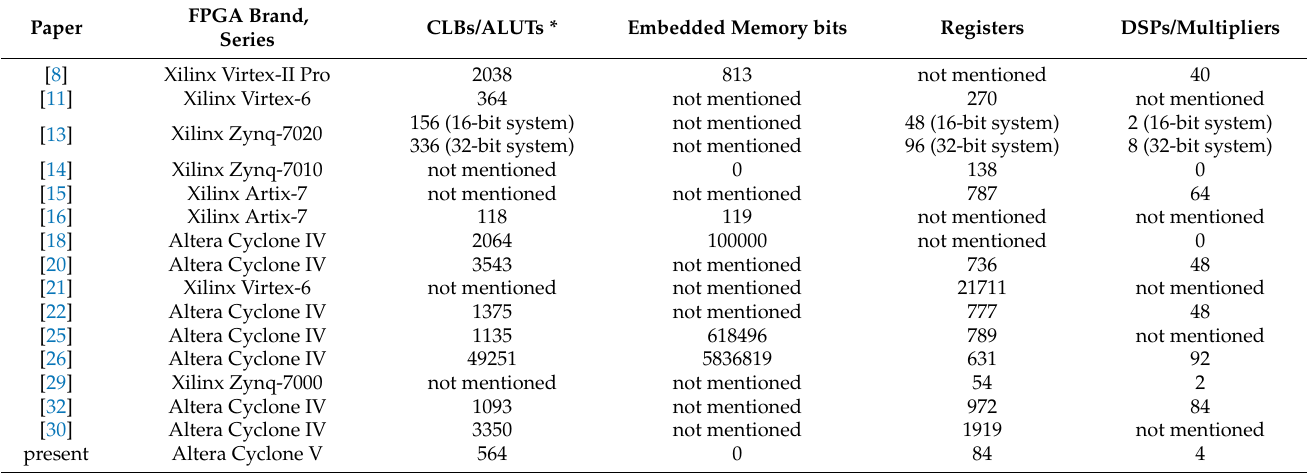
Table 3. Summary of resource usage for chaos generators implemented in FPGA.